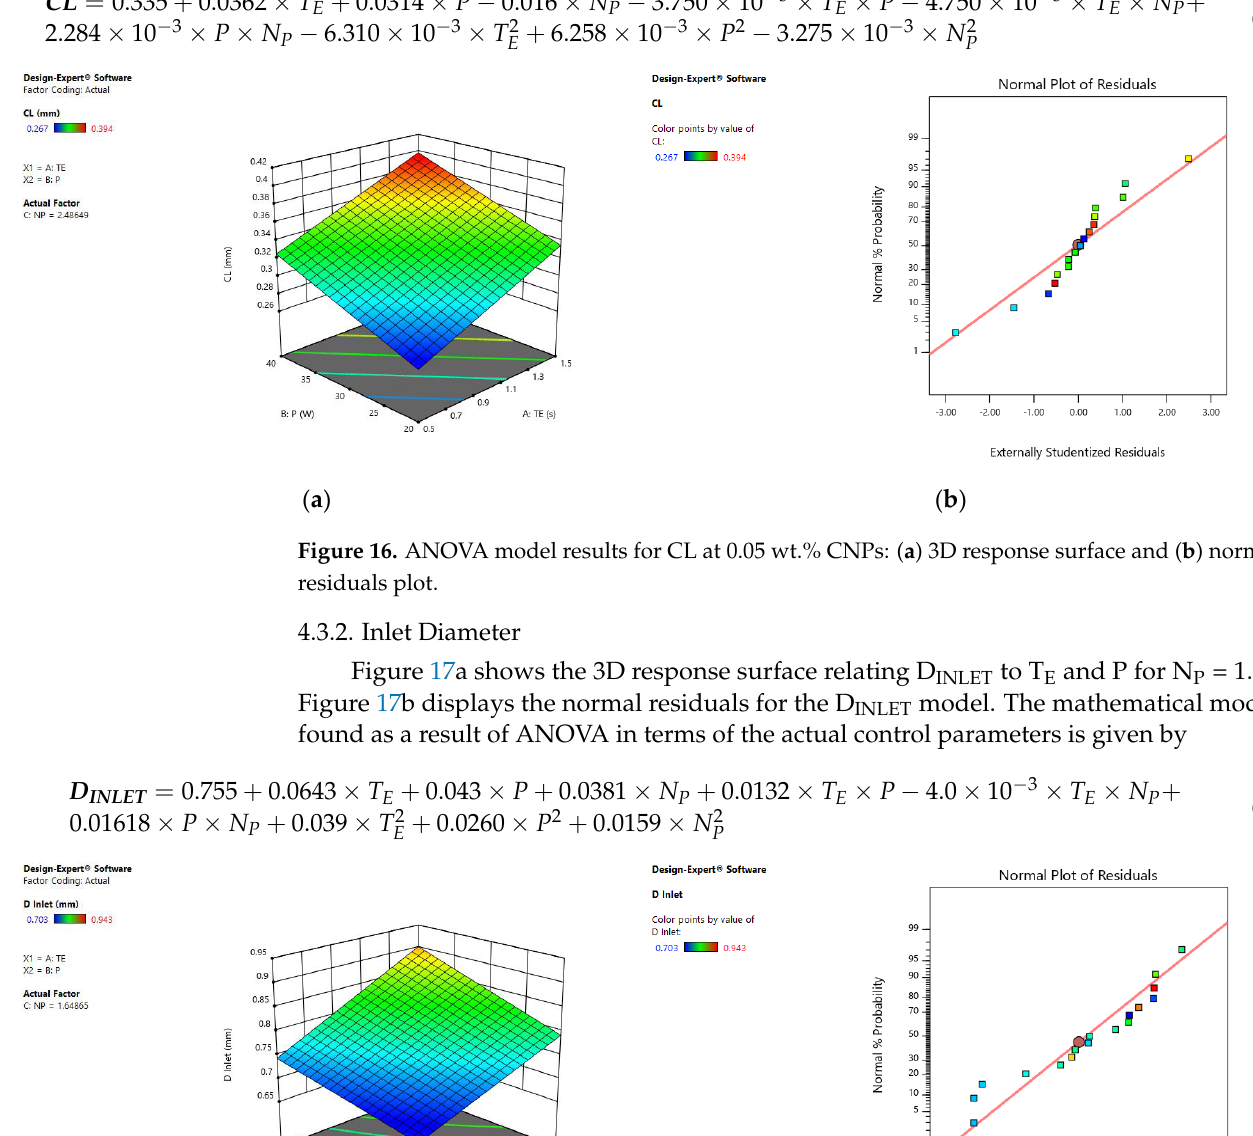
Figure 15. ANOVA model results for D INLET at 0.075 wt.% CNPs: ( a ) 3D response surface and ( b ) normal residuals plot.